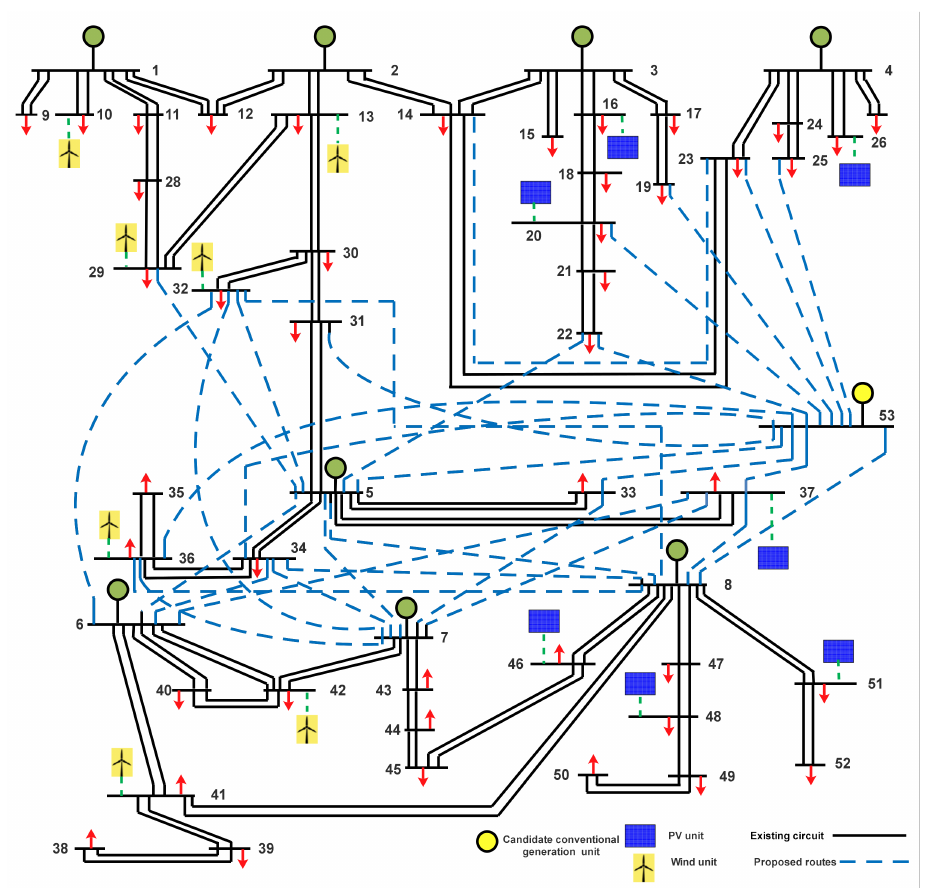
Figure 4. Candidate generation units and transmission